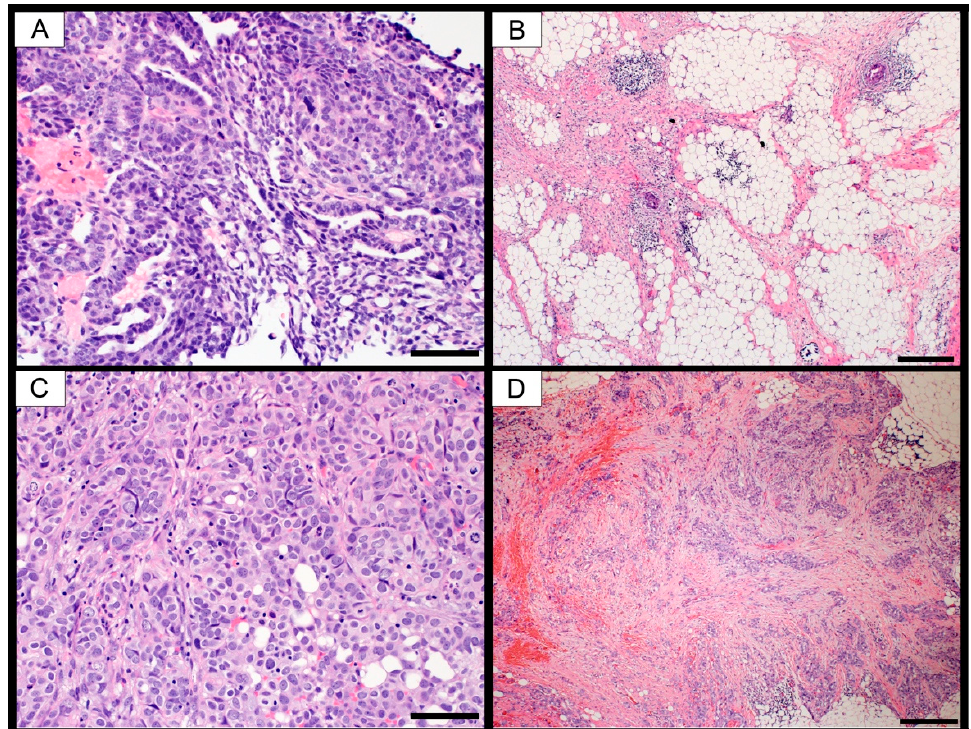
Figure 1. Photomicrographs of selected cases showing high-grade serous carcinoma. ( A ) Patient #17, high-power magnification of pre-NACT omental biopsy showing solid clusters of malignant cells with high purity and no intervening stroma. ( B ) Low-power magnification of post-NACT omental biopsy from the same patient showing CRS of 3. ( C ) Patient #1, high-power magnification of pre-NACT omental biopsy showing sheets of malignant cells with high purity and no intervening stroma. ( D ) Low-power magnification of post-NACT omental biopsy from the same patient showing CRS of 2. Scale bars: A and C = 100 µm, B and D = 500 µm. Table 1. Patient characteristics.